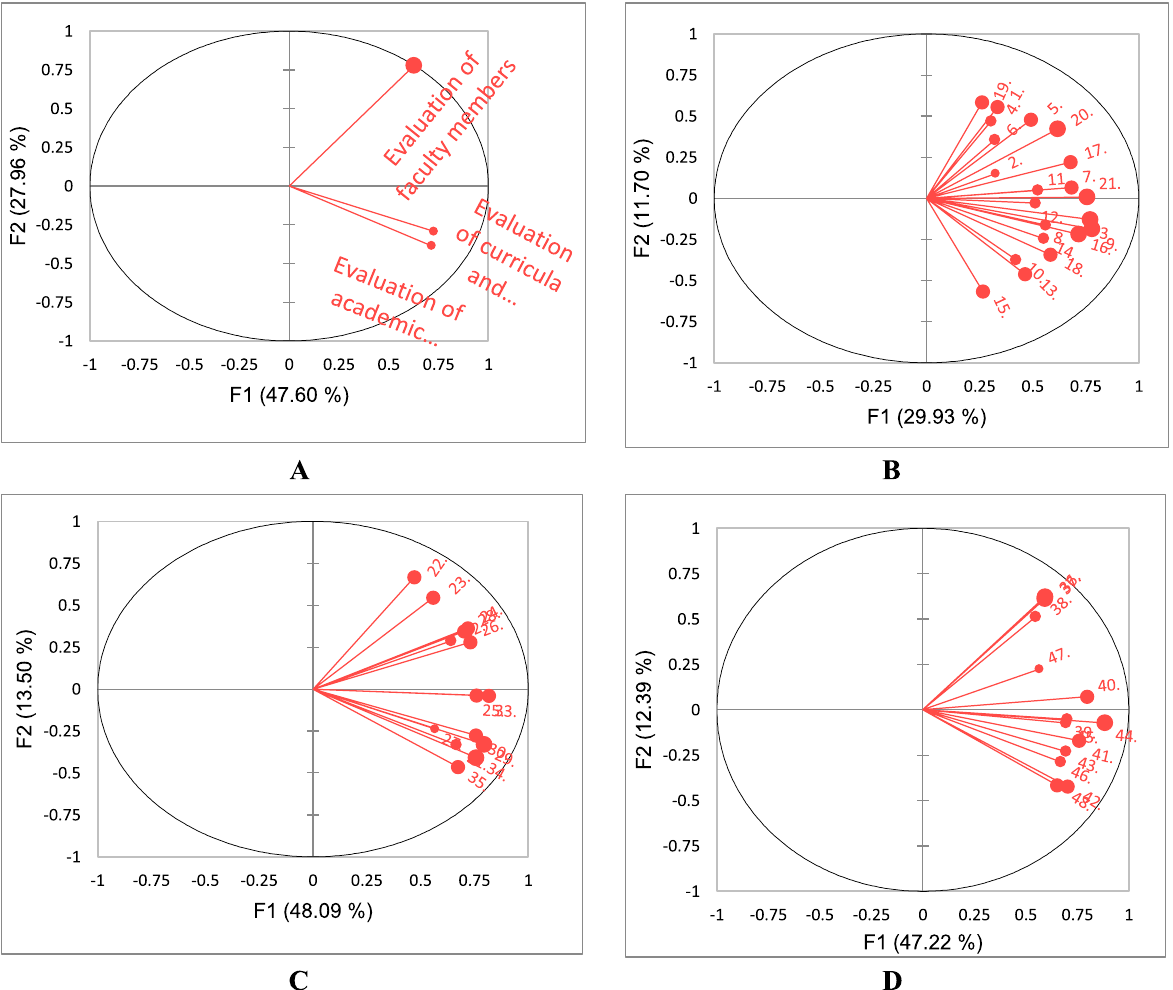
Fig. 2 Graph of the correlations between the first two components of PCA and students answers regarding student’s grade. A Students’ evaluation of three variables. B Students’ evaluation of faculty members. C Students’ evaluation of curricula and contents. D Students’ evaluation of academic support